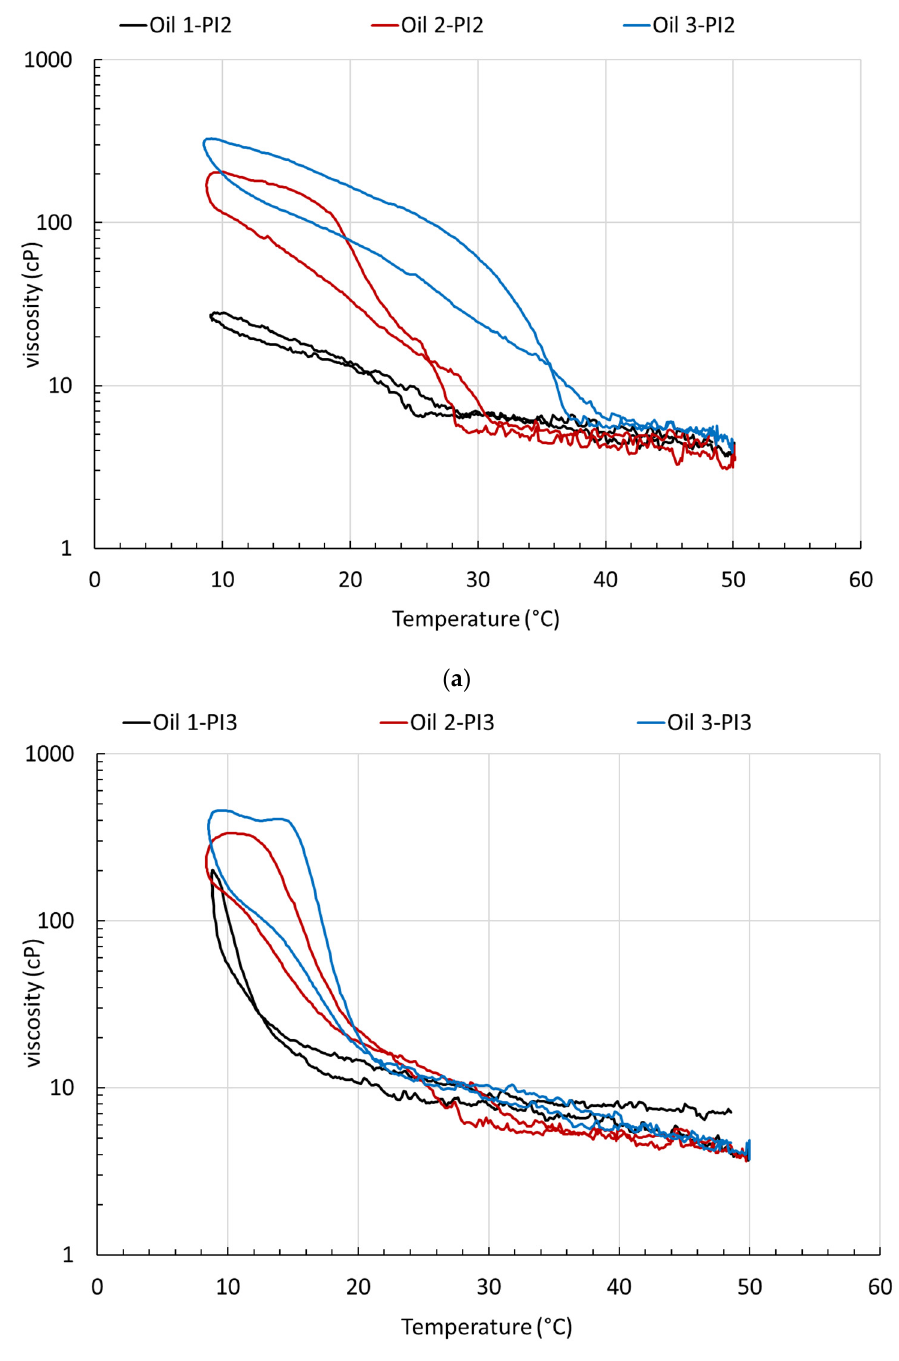
Figure 5. Viscosity as a function of the cooling/heating cycle 50 °C → 8 °C → 50 °C for oils ( a ) 1-PI2, 2-PI2, and 3-PI2 and ( b ) 1-PI3, 2-PI3, and 3-PI3, measured by applying a constant shear of 25 s − 1 and a cooling/heating rate of 1 °C/min.